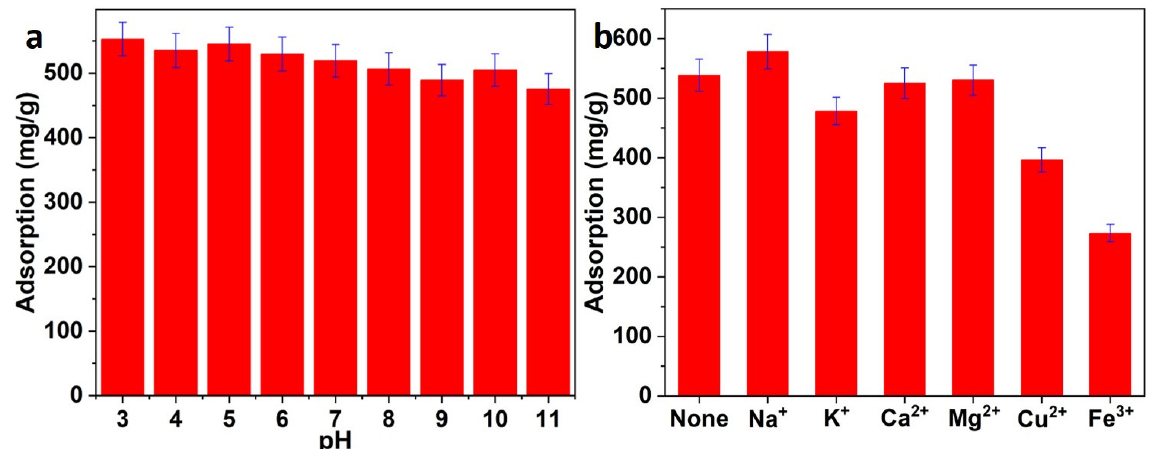
Figure 6. The influence of ( a ) different initial solution pH and ( b ) different types of ions on the adsorption of OTC by PKC-4.